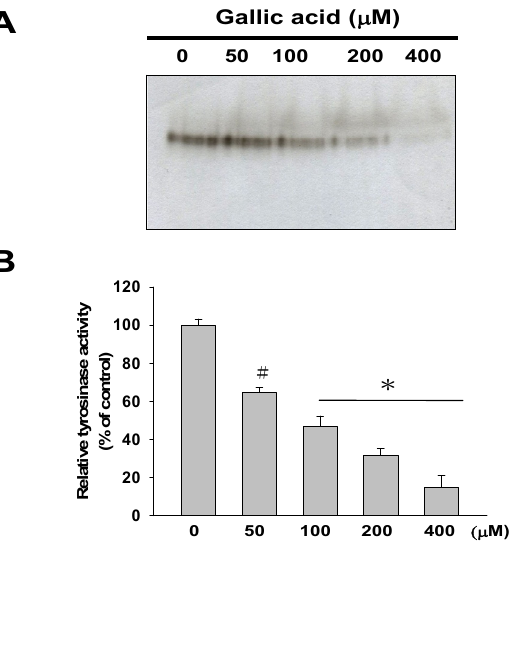
Figure 2. Tyrosinase activity and melanin synthesis in B16F10 cells with gallic acid treatment. Cells were treated with 0–400 µM gallic acid to evaluate the cellular tyrosinase activity and cellular melanin content. ( A ) Cellular tyrosinase activity stain; ( B ) Cellular tyrosinase activity assay; ( C ) Cellular melanin content. The data presented are from three independent experiments ( # p < 0.05, * p < 0.001 compared with the